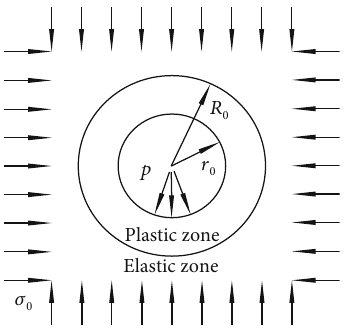
Figure 1: A simple calculation model of a